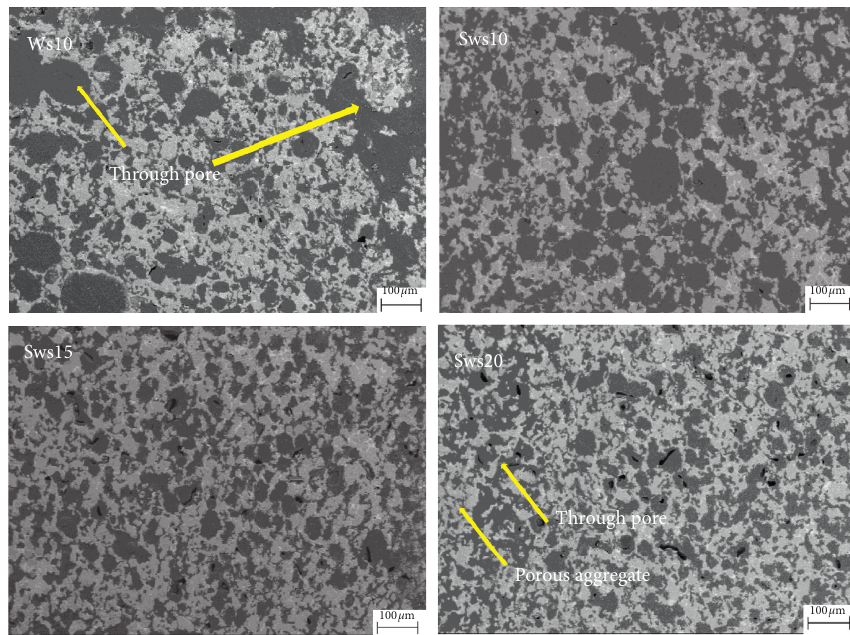
Figure 6: SEM micrographs of sintered specimens (50 × ).